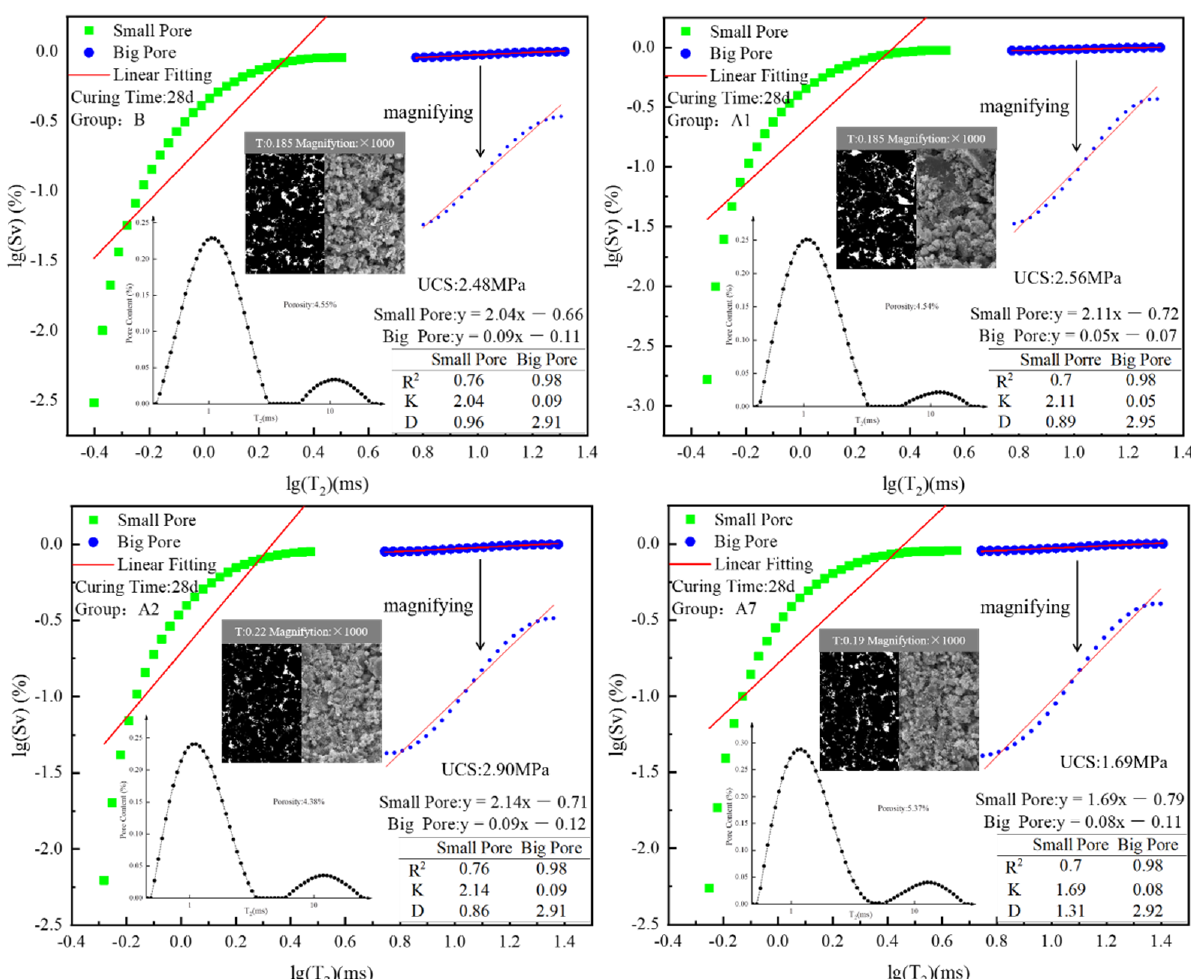
Figure 8. Fractal characteristics of representative groups.